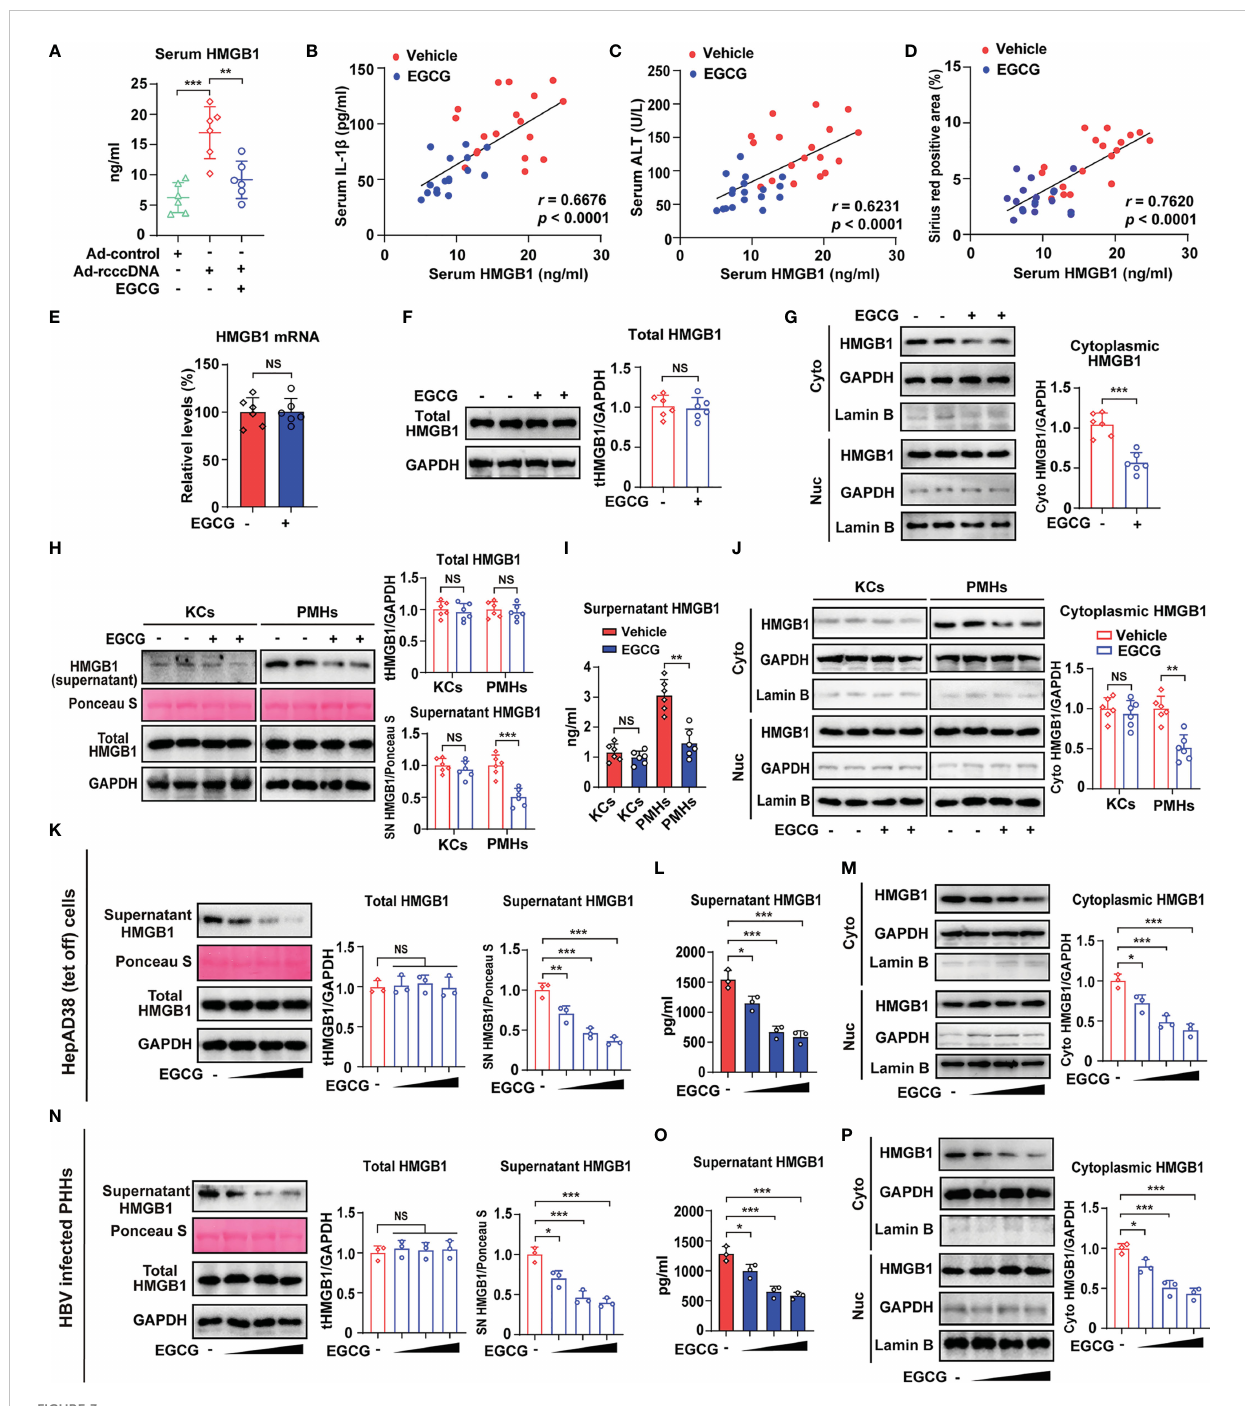
FIGURE 3 EGCG degrades cytoplasmic HMGB1 and reduces its following secretion from HBV-infected hepatocytes. (A – G) RcccDNA mice were treated with or without 25 mg/kg EGCG daily for 42 days ( n = 6). Serum HMGB1 levels were examined by ELISA (A) . Correlations of serum HMGB1 with serum IL-1 b (B) , serum ALT (C) and Sirius red-positive areas (D) in liver tissues of rcccDNA mice treated with or without EGCG. Hepatic HMGB1 mRNA levels were determined by qRT-PCR (E) . Hepatic HMGB1 protein levels (F) and HMGB1 protein levels in cytoplasmic and nucleic extracts of liver tissues (G) were determined by Western blotting. Relative HMGB1 protein levels were determined by densitometric analysis, and the value from the control group was set at 1.0. (H – J) PMHs and KCs were isolated from rcccDNA mice treated with or without EGCG ( n = 6). Protein levels of HMGB1 in supernatant and cell lysate were determined by Western blotting as in F (H) . Supernatant HMGB1 levels were determined by ELISA (I) . HMGB1 protein levels in cytoplasmic and nucleic extracts of PMHs and KCs were determined by Western blotting as in F (J) . (K – M) HepAD38 cells (Tet off) were treated with increasing dosage of EGCG (12.5, 25 and 50 m M) for 24 hours, followed by the determination of HMGB1 secretion, intracellular and cytoplasmic HMGB1 as in (F, N – P) HBV-infected PHHs were treated with increasing dosage of EGCG (12.5, 25 and 50 m M) for 24 hours, followed by the determination of HMGB1 secretion, intracellular and cytoplasmic HMGB1 as in (F) Data are shown as mean ± SEM and compared by unpaired Student ’ s t test or one-way analysis of variance (ANOVA). *P < 0.05, **P < 0.01, ***P < 0.001. NS, no signi fi